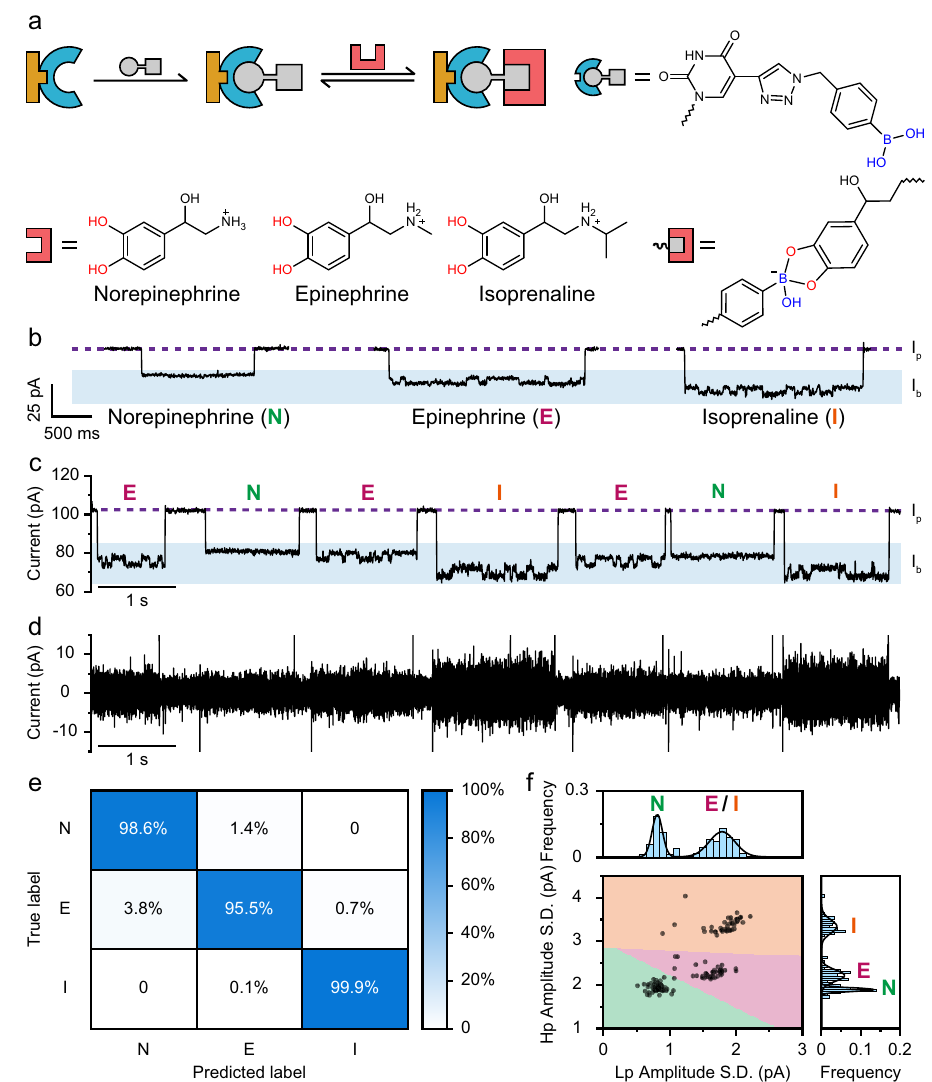
Fig. 5 PNRSS sensing of epinephrine, norepinephrine and isoprenaline. a The reaction mechanism. Norepinephrine, epinephrine and isoprenaline all contain a 1,2-benzenediol moiety, capable of binding a PBA. b Representative events of epinephrine, norepinephrine or isoprenaline binding. The events were low-pass Butterworth fi ltered with a cut-off frequency of 100Hz (Supplementary Fig. 44). All events appear negative going ( I b < I p ). c , d A representative trace containing norepinephrine-, epinephrine- or isoprenaline-binding events. The trace was Butterworth fi lter separated into the low-pass ( c ) and the high-pass ( d ) portion. The cut-off frequency is 100Hz (Supplementary Fig. 44). e A confusion matrix was generated based on 1455 events fed into a SVC model (Supplementary Fig. 45). f The scatter plot of low-pass (Lp) and high-pass (Hp) amplitude SD from PNRSS sensing of a mixture of catecholamine events (Supplementary Fig. 46). Results of 150 events are included. The decision boundary, which separates the scatter plot to green (norepinephrine), pink (epinephrine) and orange (isoprenaline) colour- coded regions, was determined by a machine learning algorithm (Supplementary Fig.